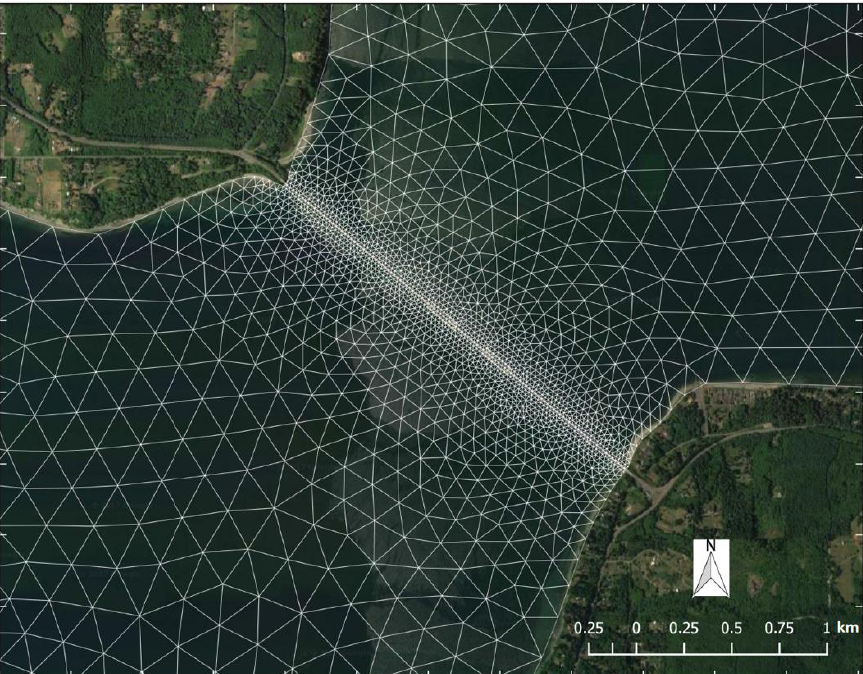
Figure 5. Salish Sea model grid with refinement in the region to facilitate incorporation of the bridge block elements. The grid size is refined such that cell centers are separated by the bridge width distance of 18.3 m. The bridge draft is represented by two layers whose combined thickness is equal to 4.57 m.